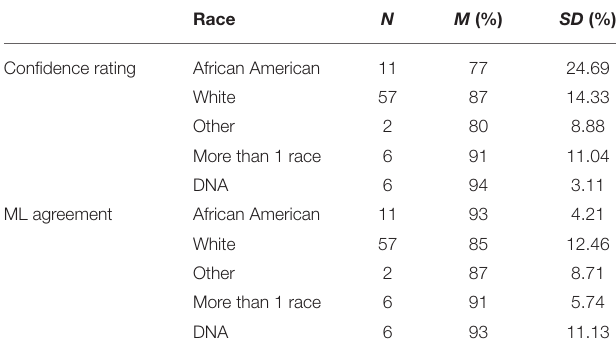
TABLE 4 | Confidence rating (OpenFace) and ML agreement as a function of race.